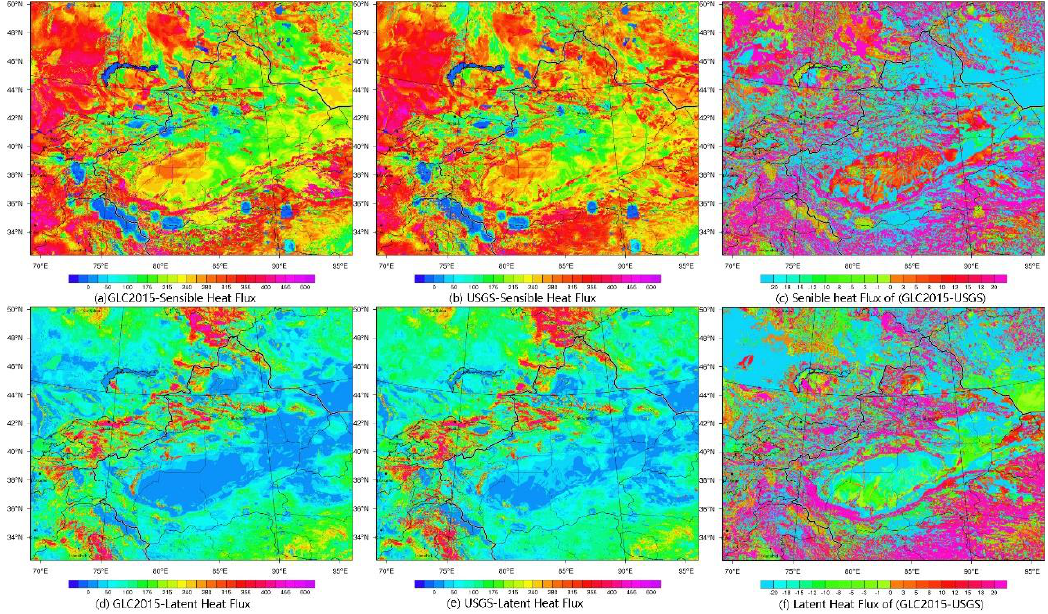
Figure 5. Contrast maps of the sensible and latent heat fluxes of GLC2015 ( a,c ) and USGS ( b,d ) and their differences at 6:00 UTC, 10 July 2018.